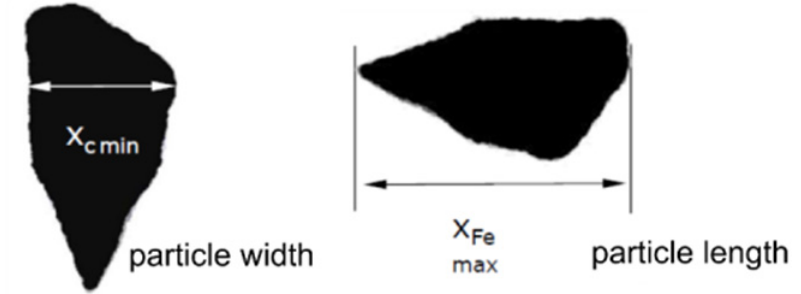
Figure 1. Two main particle size parameters analyzed with Particle Analyzer Camsizer: particle width ( x cmin , the shortest chord diameter), particle length ( x Femax , the longest Feret diameter) (adapted from [44].).